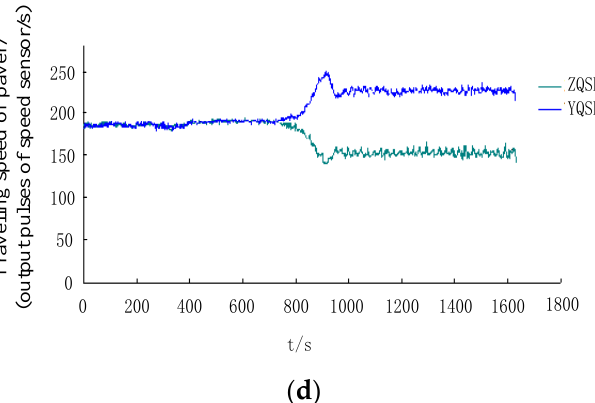
Figure 6. Constant speed test of paver when turning. ( a ) Constant speed test of the paver with a new control scheme when turning (maximum position of steering knob). ( b ) Constant speed test of the paver with the old control scheme when turning (maximum position of steering knob). ( c ) Constant speed test of the paver with the new control scheme when turning, (the steering knob is turned to 1/2 of the maximum position). ( d ) Constant speed test of the paver with the old control scheme when turning (the steering knob is turned to 1/2 of the maximum position). ZQSD — Speed of the left wheel, YQSD — speed of the right wheel.